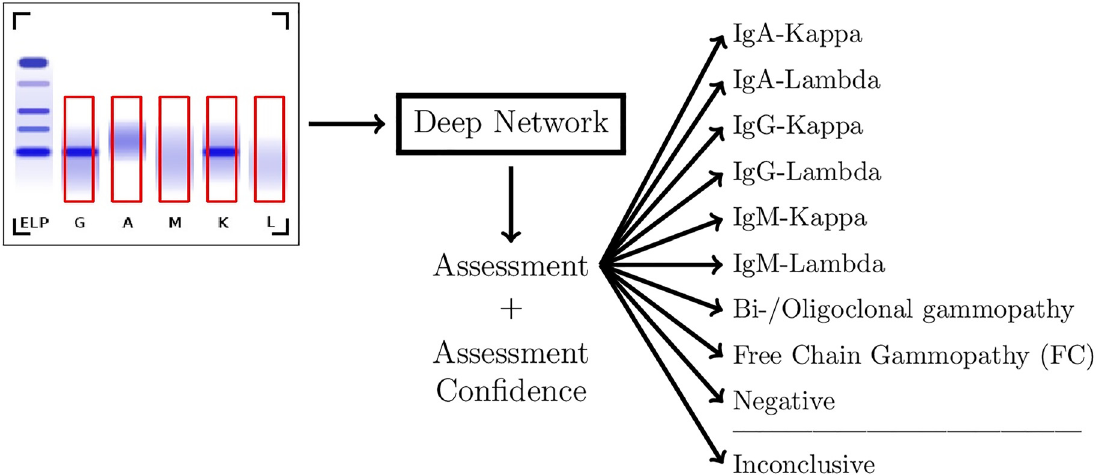
Figure 2: Flowchart of the assessment